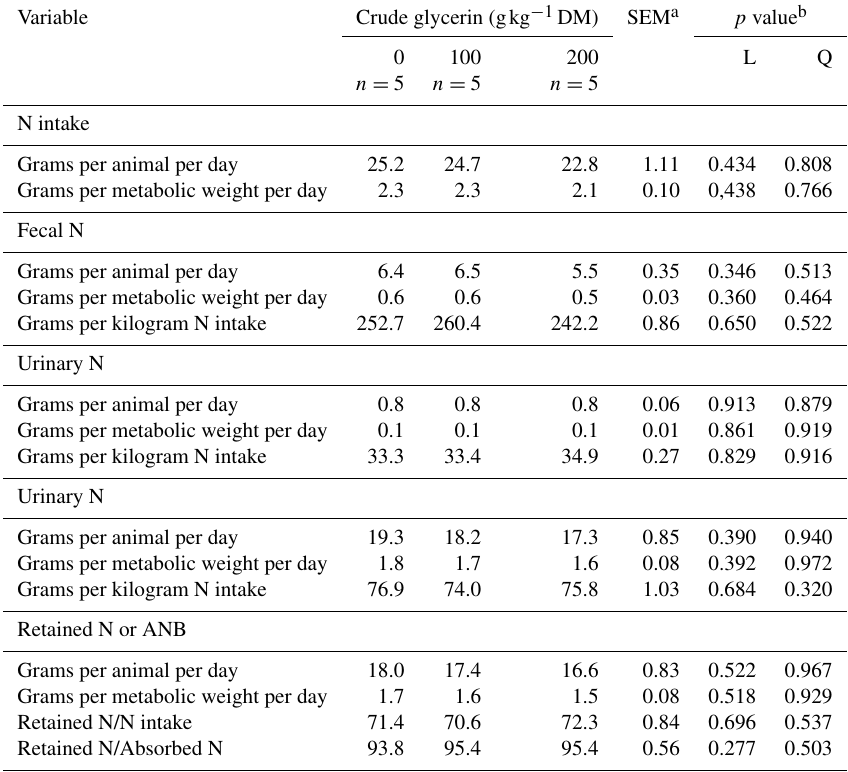
Table 4. Apparent nitrogen balance (ANB) in feedlot lambs fed diets containing crude glycerin.